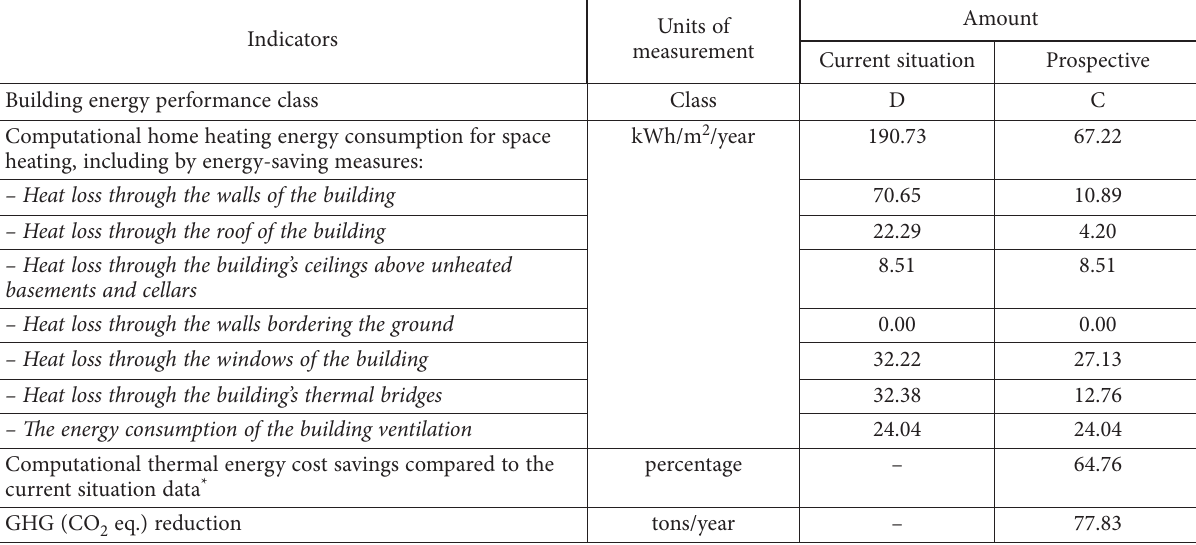
Table 11. Predicted energy savings after refurbishment for Alternative